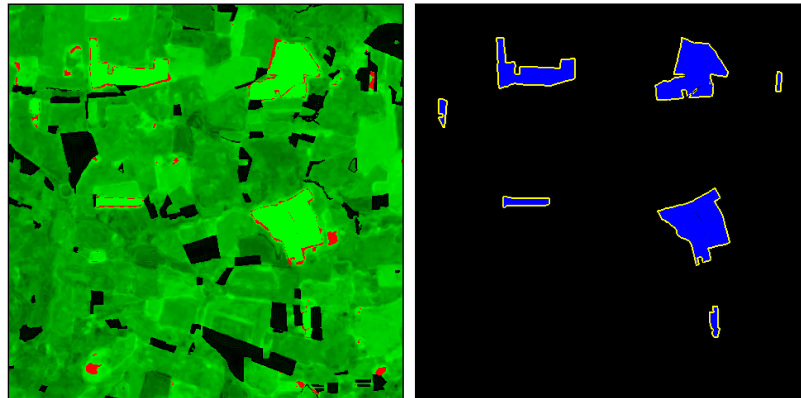
Figure 12. The classification confidence and the errors of the proposed method for spring oats. The color bar and scale are the same as in Figure 11.